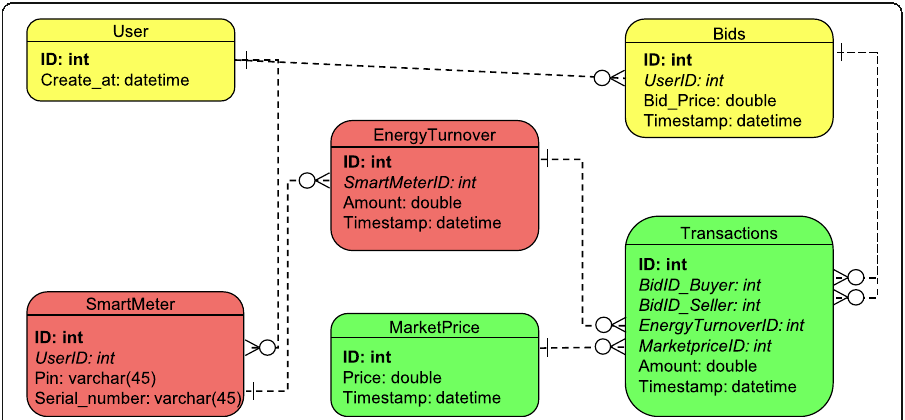
Fig. 5 Database setup as EER-Model